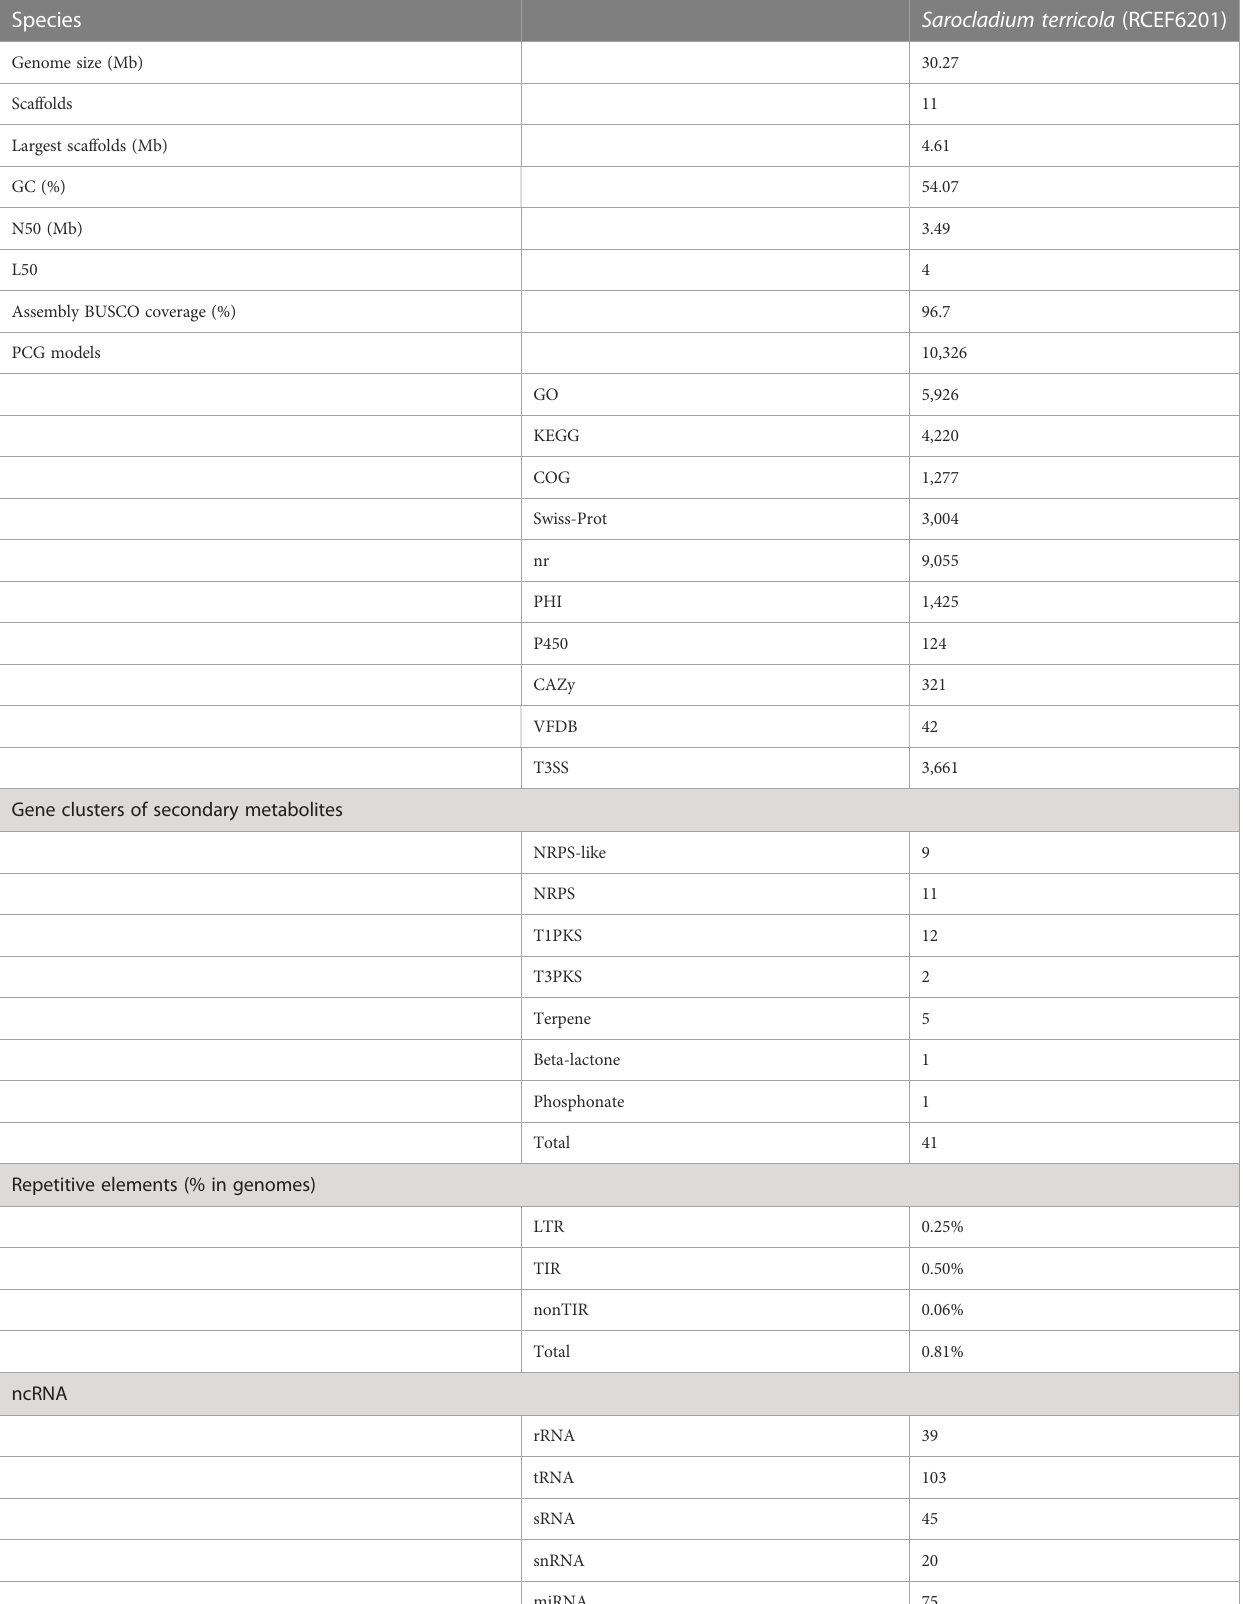
TABLE 1 Genomic features of Sarocladium terricola sequence